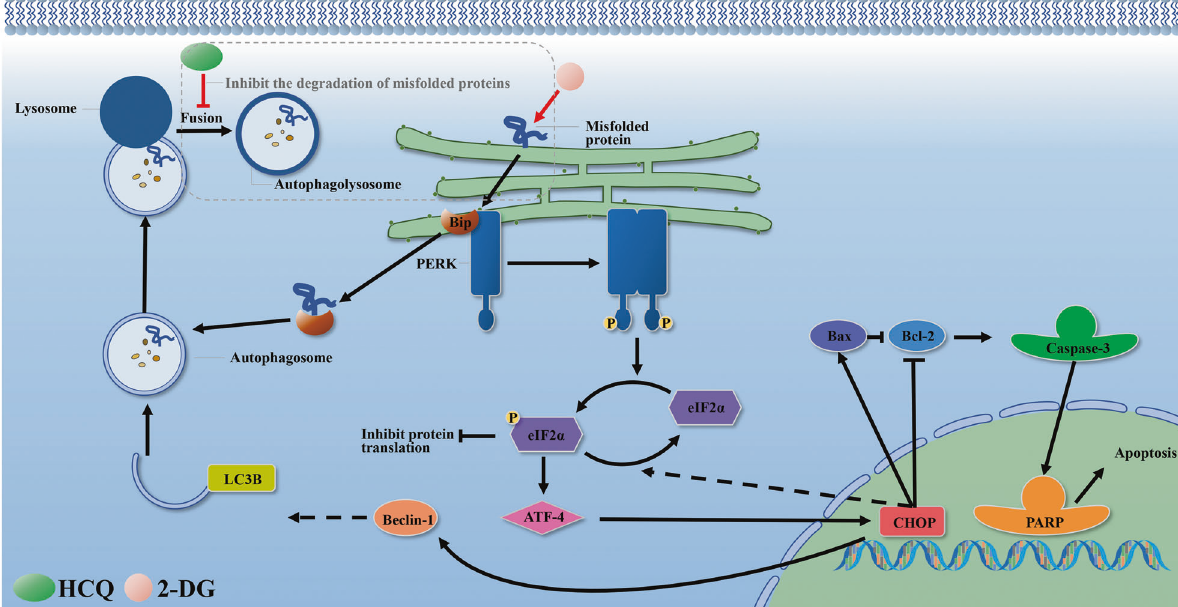
Fig. 6 Schematic illustration delineating the role of HCQ/2 ‐ DG combination therapy. The metabolites of 2-DG interfere with the N-linked glycosylation of proteins, leading to the accumulation of unfolded/misfolded proteins in the ER, followed by ERS, apoptosis, and cytoprotective autophagy. HCQ causes deacidi fi cation of lysosomes, inhibits the fusion of autophagosomes and lysosomes to form autolysates, which results in the inhibition of misfolded protein degradation and further induces endoplasmic reticulum stress, ultimately leading to increased